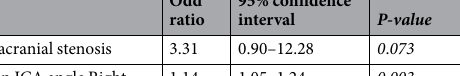
95% confidence interval